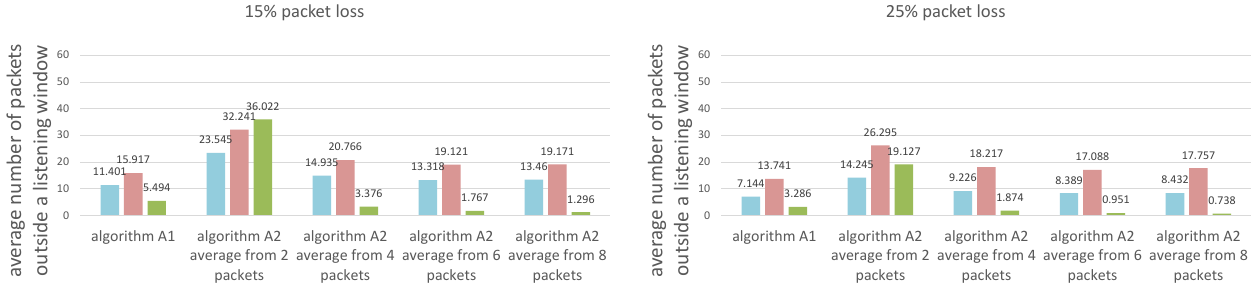
algorithm A1 algorithm A2